Question: Draft a figure caption describing what is shown.
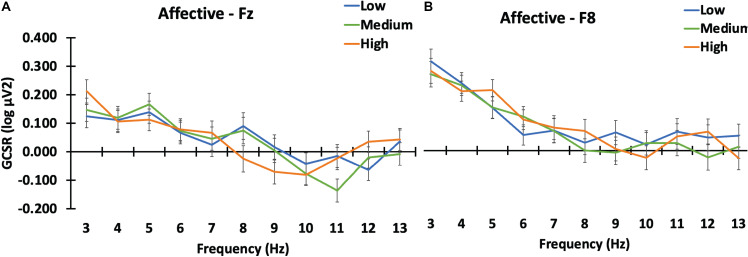
Answer: EEG power of affective groups on GCSR at Fz and F8. Note: The Y axis represents the EEG power (log µV 2 ) for the GIS (GCSR) measure. Affective groups are: low (blue); medium (green; and high (orange). The X-axis is the frequency (Hz). A . Findings at Fz. B . findings at F8. Error bars represent standard error.